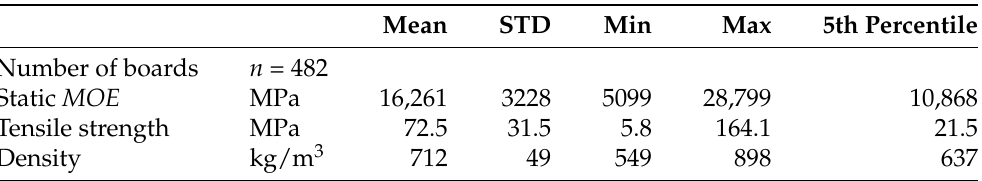
Table 3. Results of grade determining properties of all boards.